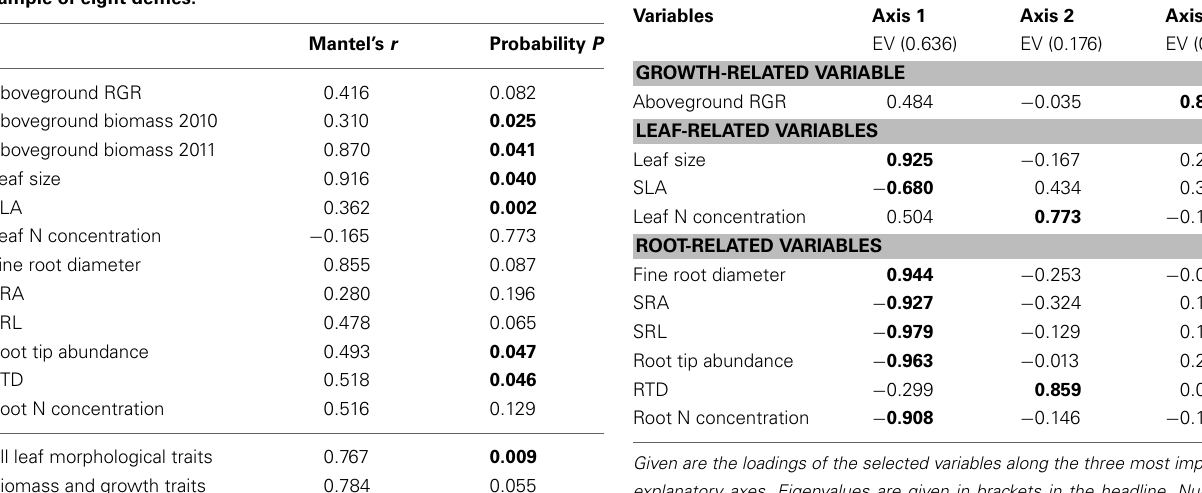
Table 6 | Results of a Mantel test conducted to analyse the relationship between morphological trait variance (first matrix) and genetic variance according to AFLP markers (second matrix) in the sample of eight demes.